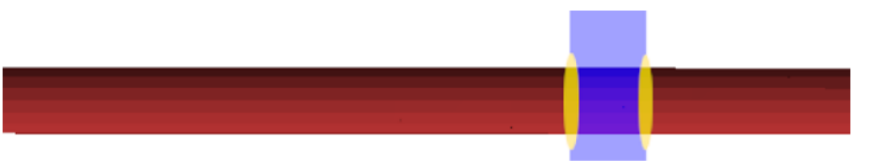
Figure 5. Zoomed in visualization of the first build path. Red represents the pathing for wall con- struction, blue is the cross-section of the oak leaf at its stem for its first layer, and yellow areas rep- resent points of intersection.